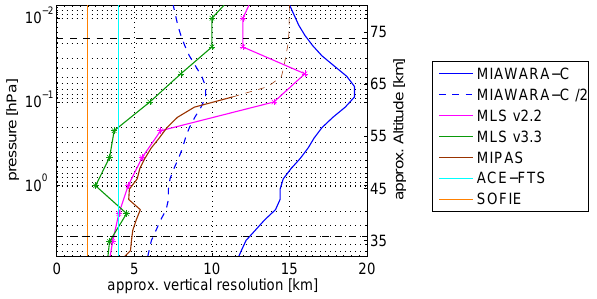
Fig. 6. Approximate vertical resolution of MIAWARA-C v1.1 and MIAWARA (blue), Aura MLS v2.2 (pink), Aura MLS v3.3 (green), MIPAS V5R H2O 220 (brown) ACE-FTS (orange) and SOFIE (cyan). Above 0.1hPa, MIPAS data are not used for the compari- son and its vertical resolution is shown as a dotted line. The values for ACE-FTS and SOFIE are given by the instruments’ field of view and are constant with altitude. For Aura MLS v2.2 and v3.3, the as- terisks indicate the values specified in Livesey et al. (2007,